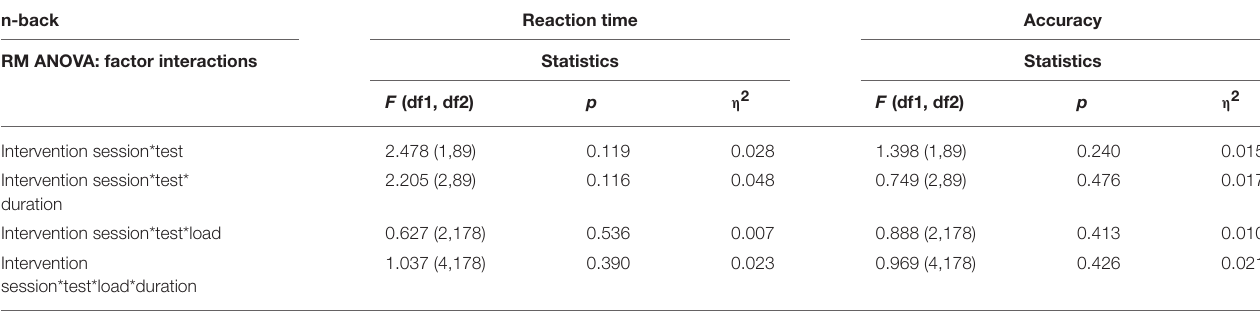
TABLE 5 | F-statistics of the RM ANOVA model for the n-back data (reaction time and accuracy).